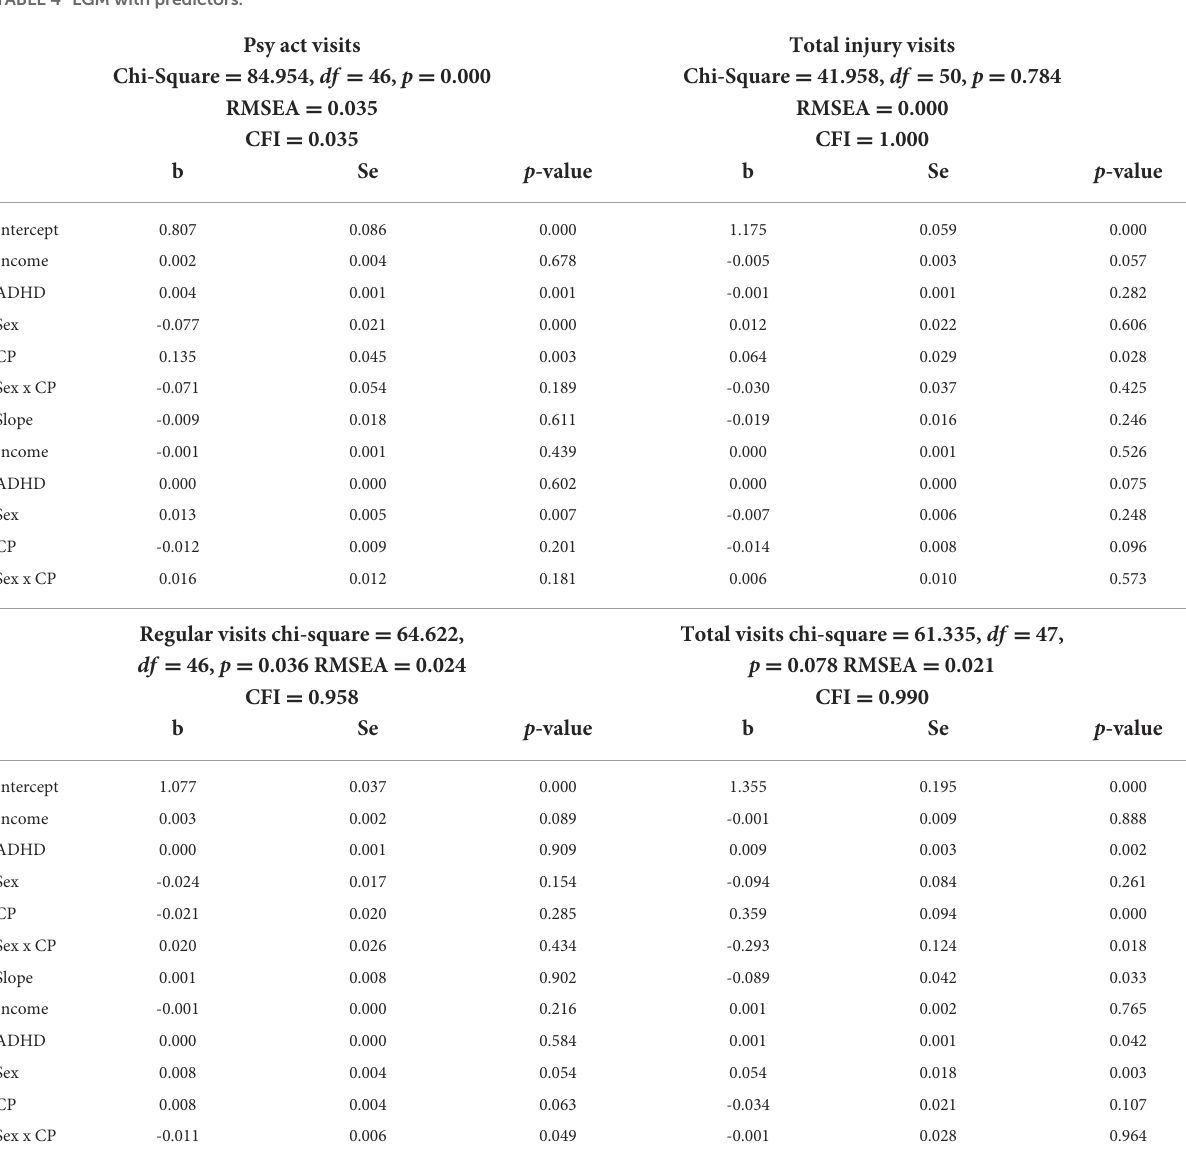
TABLE 4 LGM with